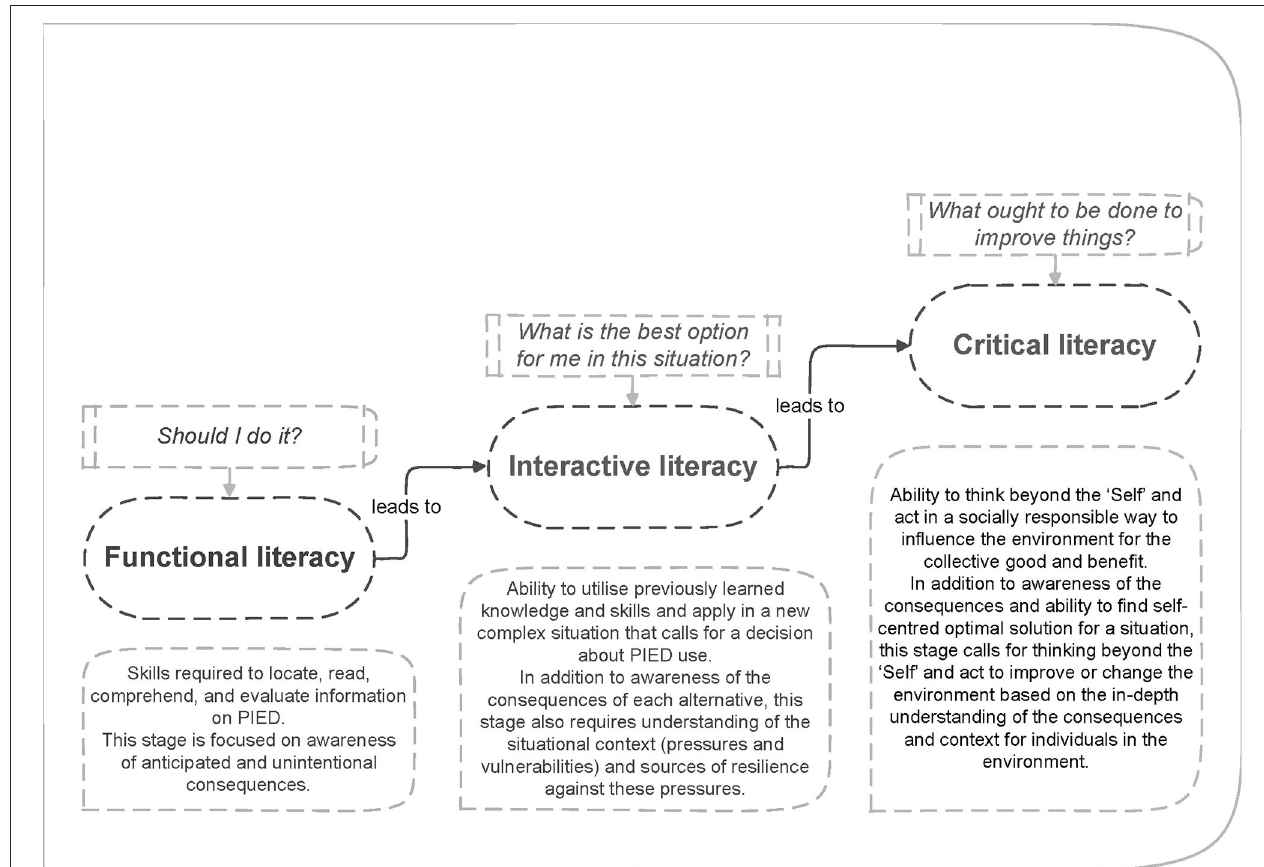
FIGURE 1 | Schematic diagram of the Doping Awareness Literacy (DAL)